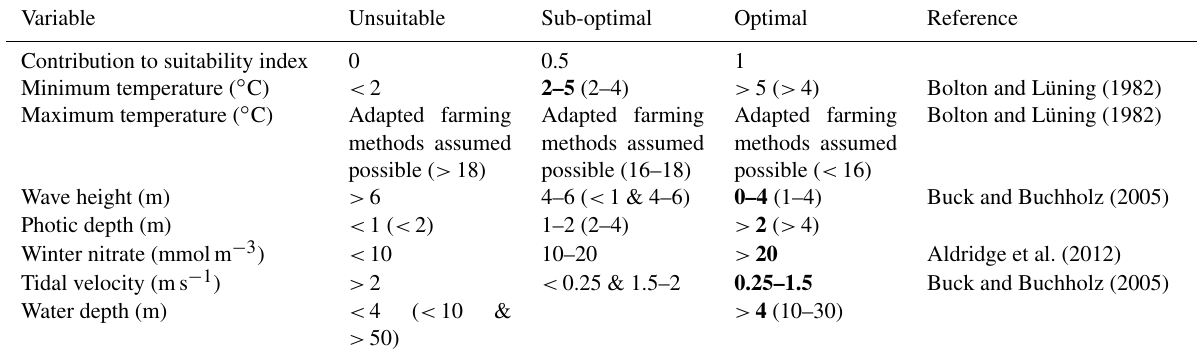
Table 5. Limiting environmental variables for macroalgae cultivation. Ranges in bold were satisfied within the selected farm area (green rectangle in Fig. 3). Between brackets: values suggested by Capuzzo et al. (2014) if